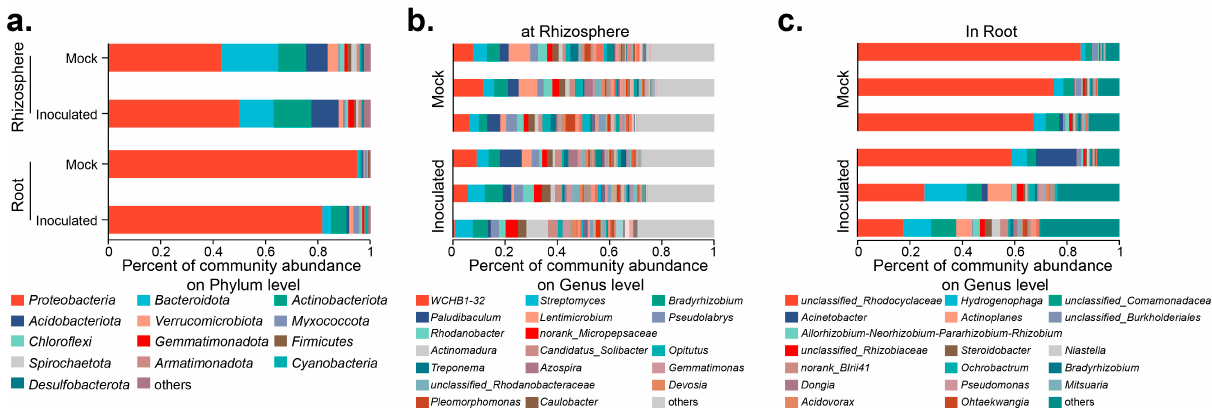
Figure 3. Microbial composition in rhizosphere and roots 30 days after B. paralicheniformis RP01 inoculation. ( a ) Relative abundance at phylum level in different groups. ( b ) Relative abundance at genus level in the rhizosphere samples. ( c ) Relative abundance at genus level in the root samples.